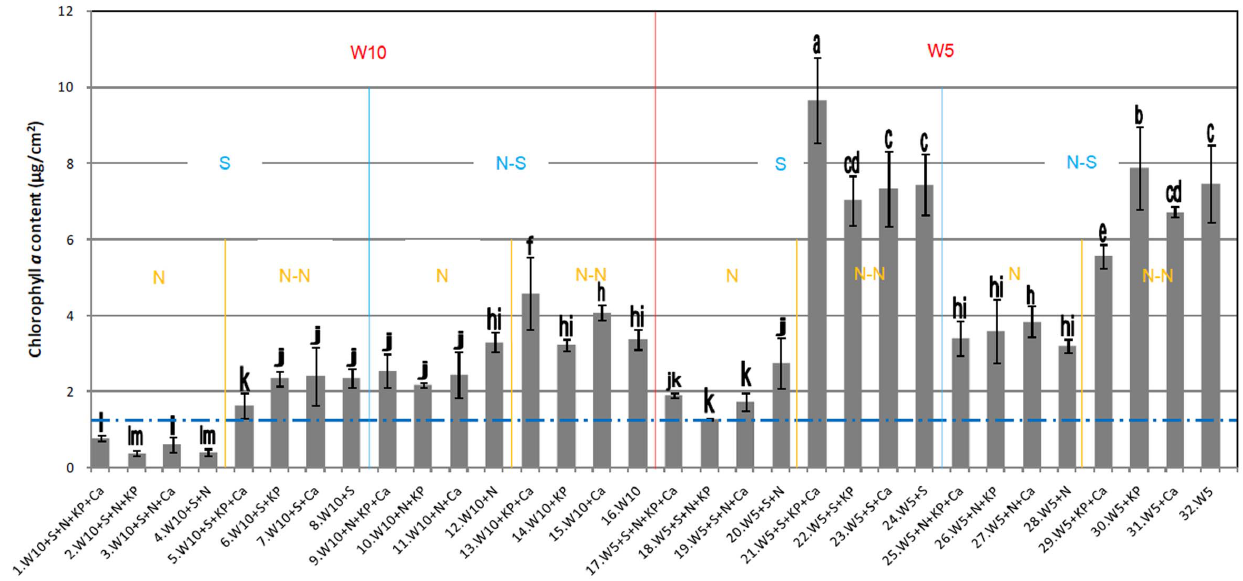
positioned 20 cm above the pot. NS: no shading. N: 2.10 g NH 4 NO 3 added to each pot. NN: no NH 4 NO 3 added to any pots. KP: 1.05 g KH 2 PO 4 added to each pot. NKP: no H 2 PO 4 added to any pots. Ca: 2.10 g CaCO 3 added to each pot. NCa: no CaCO 3 added to any pots. The capital letters indicate the different treatments, while different lower case letters above the bars indicate significant differences between any two treatments at P , 0.01.